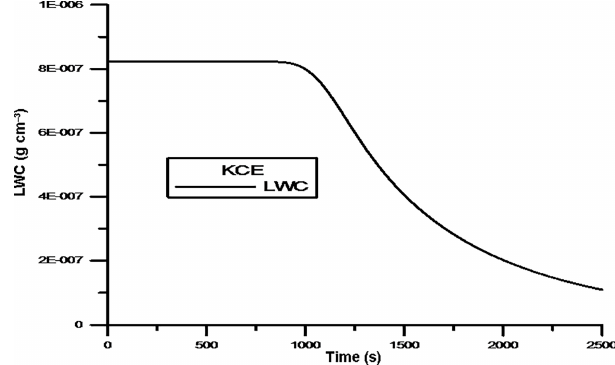
Figure 6. Time evolution of the total liquid water content calculated from the analytical solution of the kinetic collection equation for the product kernel.